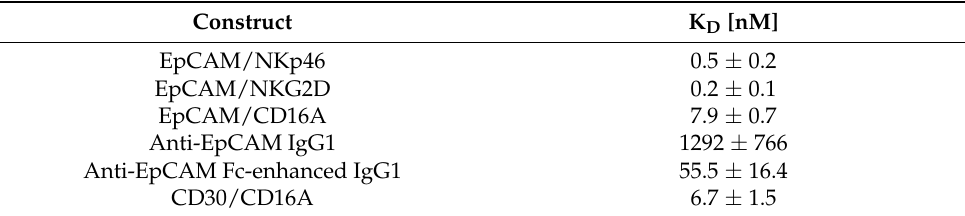
Figure 3. Binding of ICE ® constructs and control antibodies to primary human NK cells. Enriched primary human NK cells were incubated with serial dilutions of anti-EpCAM/CD16A ICE ® , anti-EpCAM IgG1, anti-EpCAM Fc-enhanced IgG1, and CD30/CD16A ICE ® as a control ( A ), and EpCAM/NKp46 and EpCAM/NKG2D ICE ® constructs ( B ) at 37 ◦ C. The cell-surface bound ICE ® constructs and control antibodies were detected with FITC-conjugated goat anti-human IgG Fc and the flow cytometric analysis. Data from a single representative experiment out of three experiments are presented. FITC, fluorescein isothiocyanate. Table 4. Apparent affinities of bispecific ICE ® constructs and control antibodies on enriched primary human NK cells measured by flow cytometry.